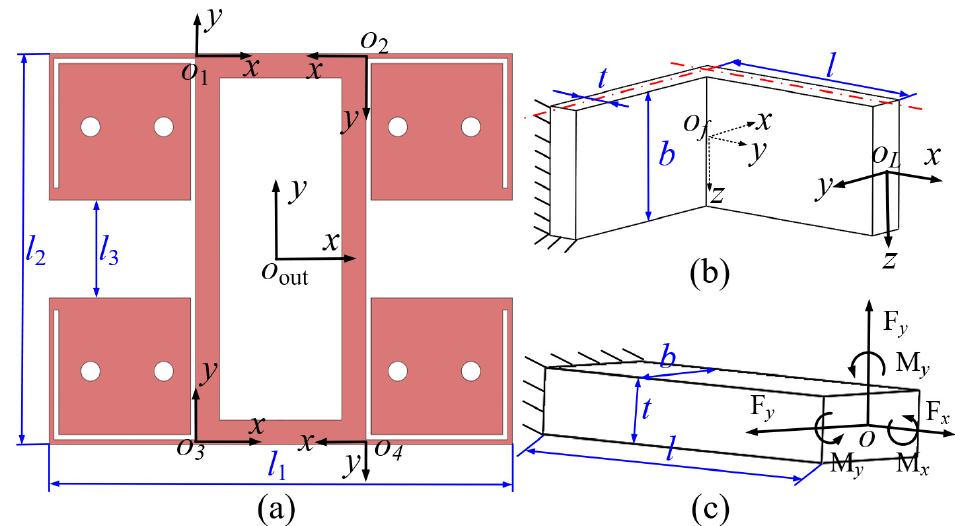
Figure 3. Schematic of the designed compliant mechanism. ( a ) The designed compliant mechanism. ( b ) The leaf flexure. ( c ) The L-shaped